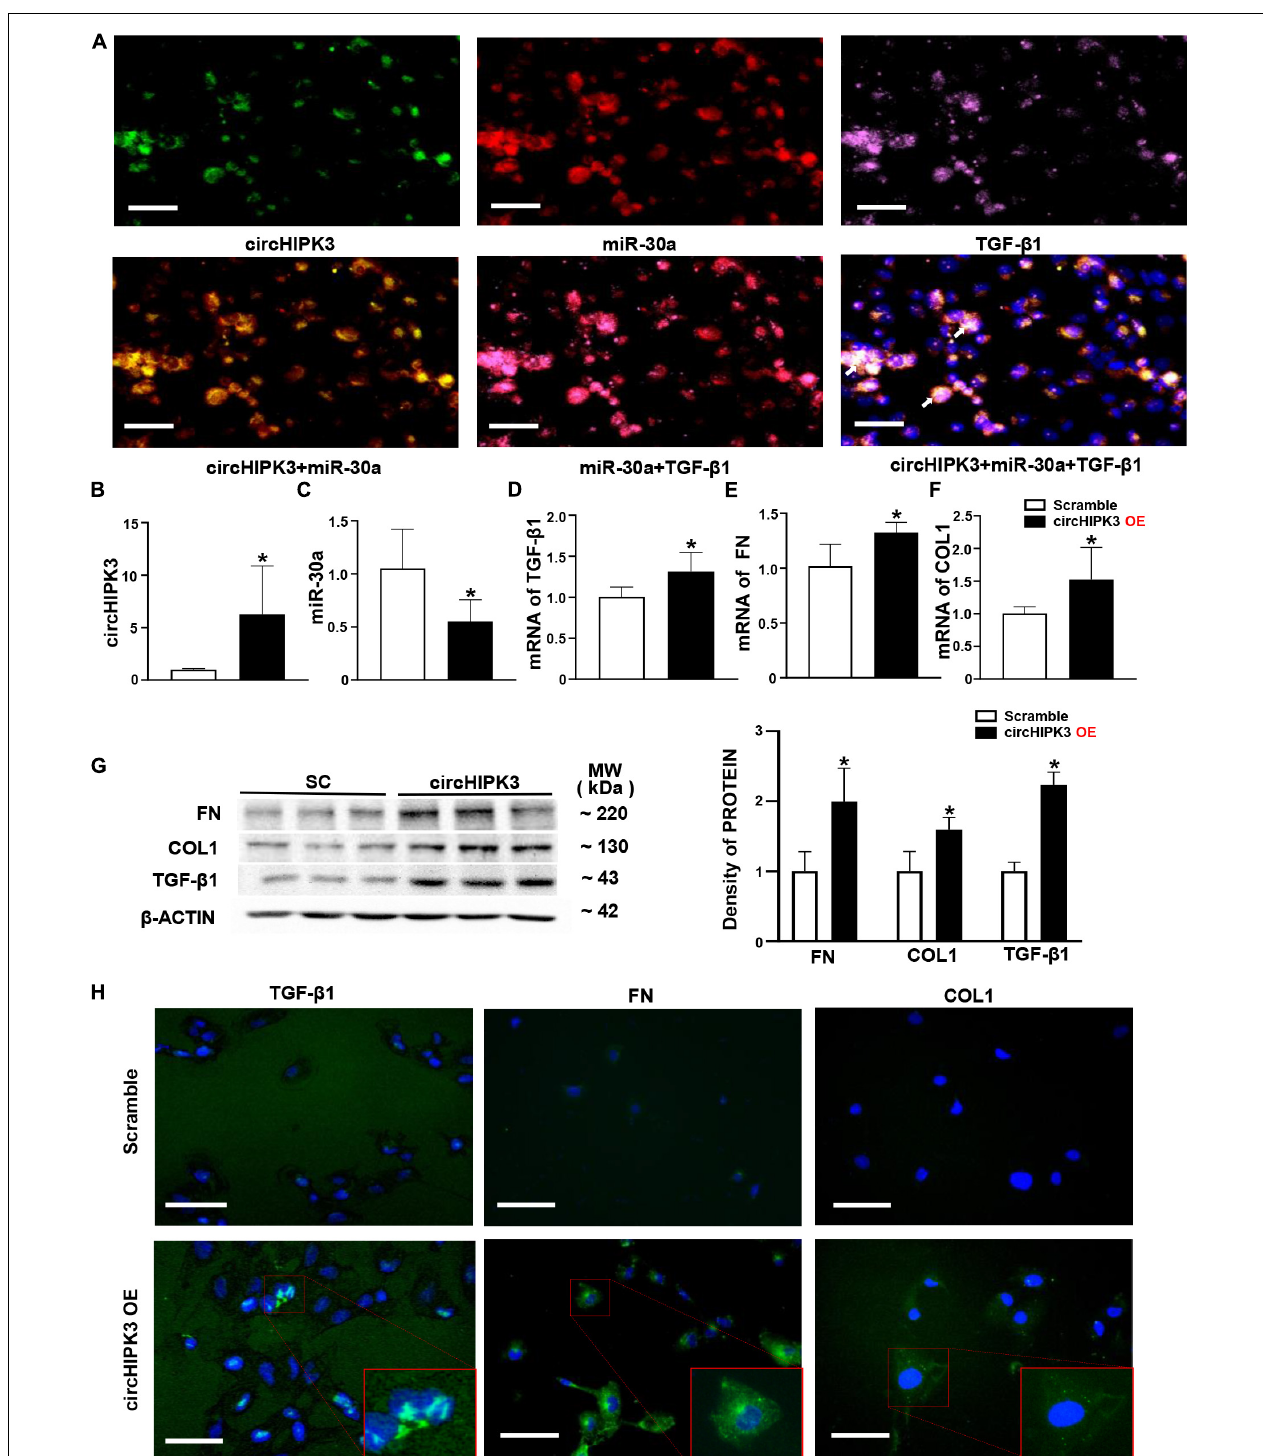
FIGURE 3 | Overexpression of circHIPK3 in HK-2 cells. (A) The colocalization in the cytoplasm of circHIPK3, miR-30a, and TGF- β 1 is shown. (B) The levels of circHIPK3 on qPCR after circHIPK3 overexpression. (C–F) The levels of miR-30a, TGF- β 1, fibronectin (FN), and collagen 1 (COL1) using qPCR after overexpression of circHIPK3. (G) Protein levels of FN, COL1, and TGF- β 1 on immunoblotting and semi-quantitative analysis after the overexpression of circHIPK3. (H) The expression of TGF- β 1, FN, and COL1 assessed by immunofluorescence with circHIPK3 overexpression. Magnification 400 × , bar scale: 100 µ m. n = 6 in each group, * p < 0.05, circHIPK3 vs. scrambled